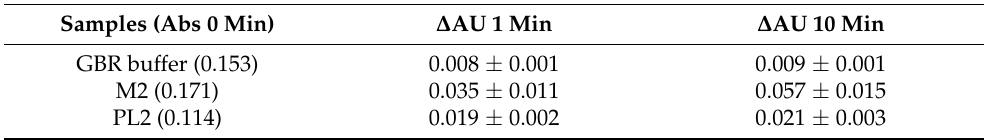
Table 6. Increase of cornea absorbance ( ∆ AU) after contact with microemulsion systems and with glutathione bicarbonate Ringer (GBR) buffer.